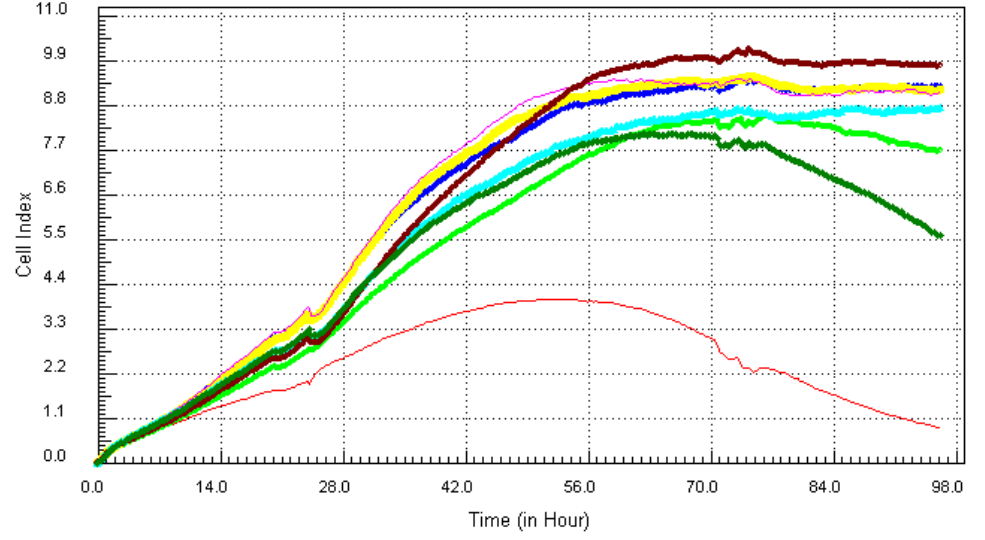
Figure 4. Kinetics of cytotoxic responses for lead (Pb) in MCF7 cells as described in Figure 1 legend.